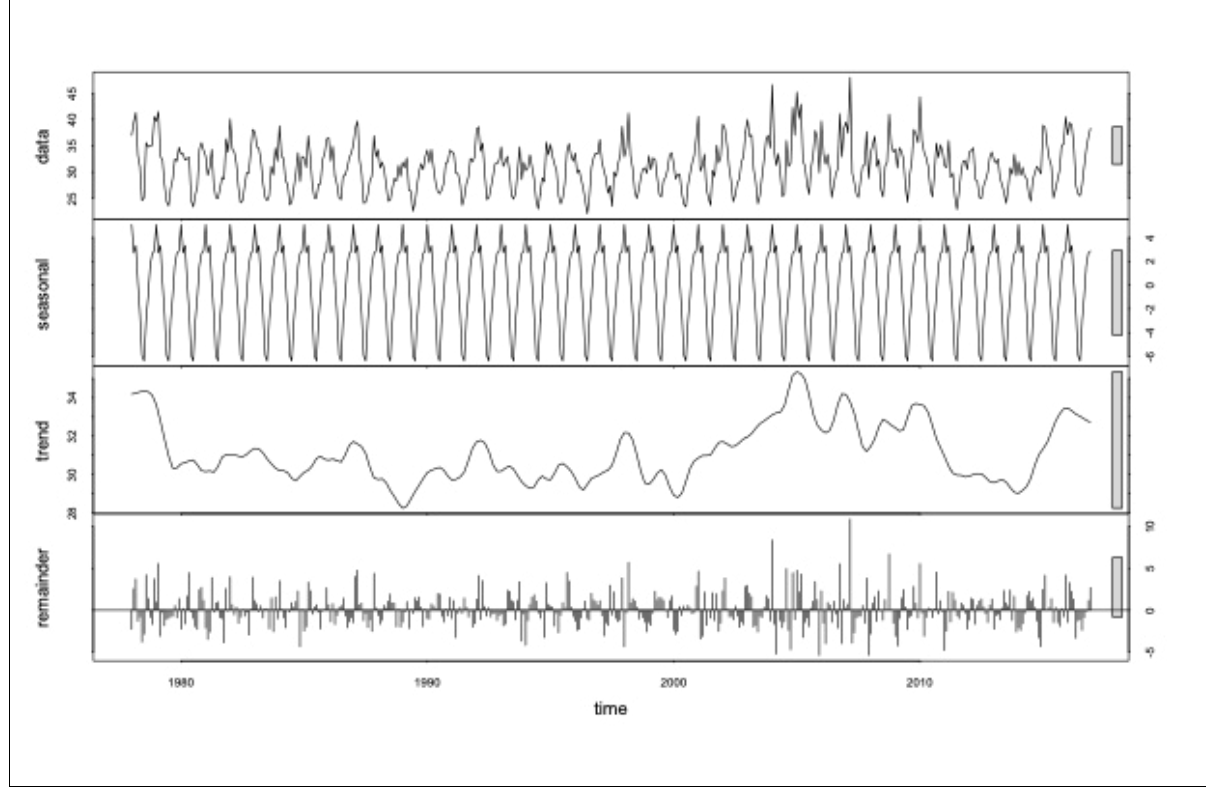
Figure 10: Seasonal and trend decomposition of the heat index (°C) for northernmost Limpopo Province, 1980–2016. ‘Data’ = set of actual values; ‘seasonal’ component = period; ‘trend’ = increasing or decreasing direction in the data; and ‘remainder’ = residual. The grey bar at the right-hand side of each graph allows for a relative comparison of the magnitudes of each component.